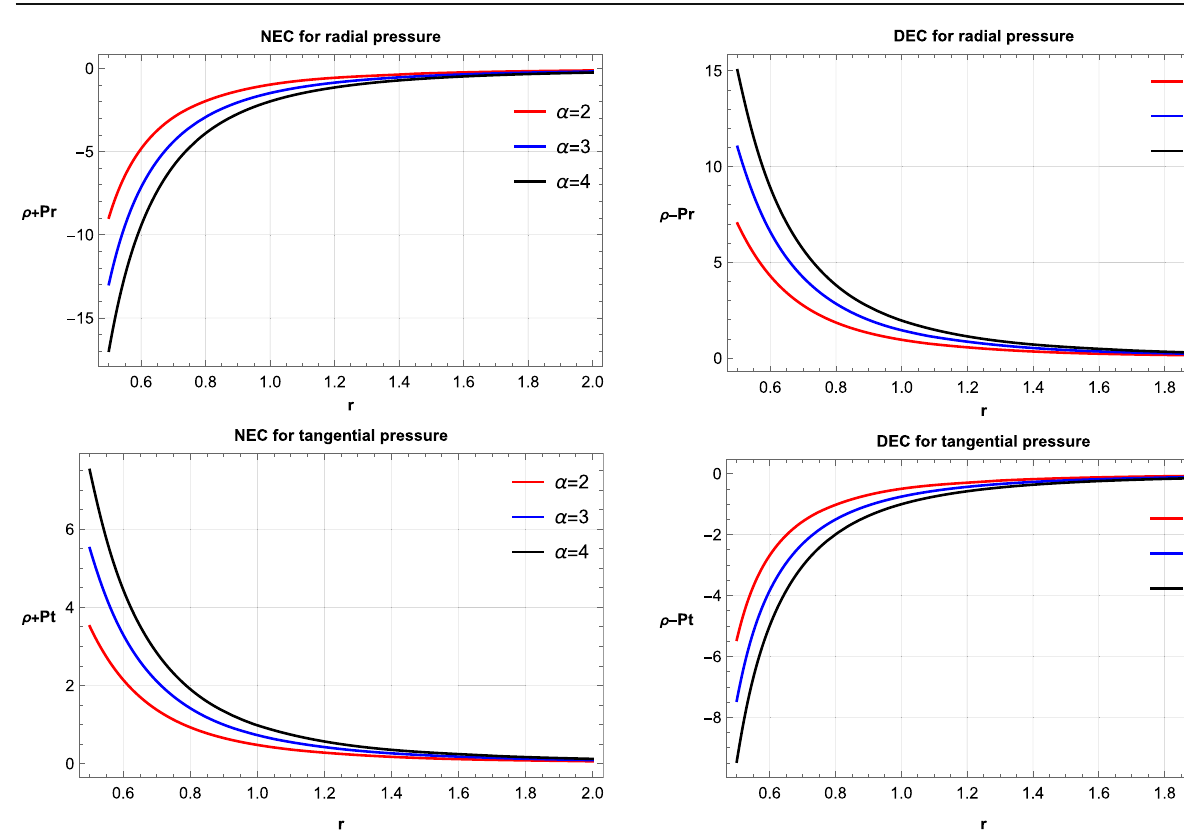
Fig. 8 The variation of DEC against r for parallel cylinder with r 0 = 0 .